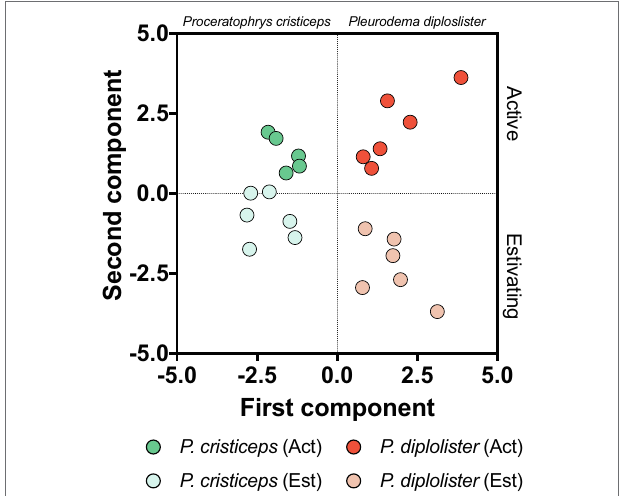
FIGURE 6 | Principal component analysis of biomarkers of key metabolic pathways, endogenous antioxidants, redox imbalance, and oxidative stress. Each circle corresponds to an individual. Note that the group of active Proceratophrys cristiceps has only five individuals, since one of the analyzed variables (catalase activity) was measured in only five animals in this group. The resulting coefficients for each principal component are shown in Table 3 . Data for P. cristiceps , previously published in Moreira et al. (2020) and summarized in Table 1 , were included in the